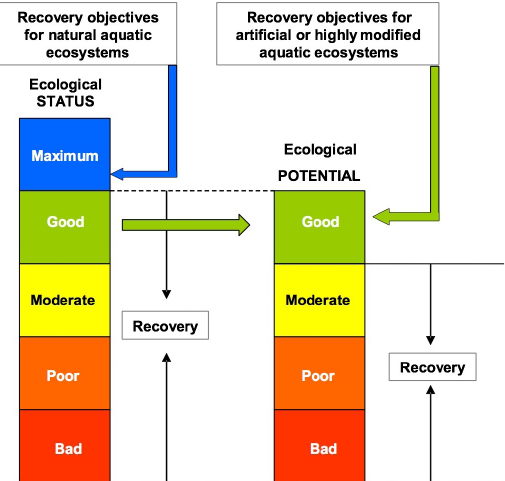
Figure 2. Comparison between Ecological Status (for natural ecosystem) and Ecological Potential (for artificial or highly modified environments) from the European WFD (EC,